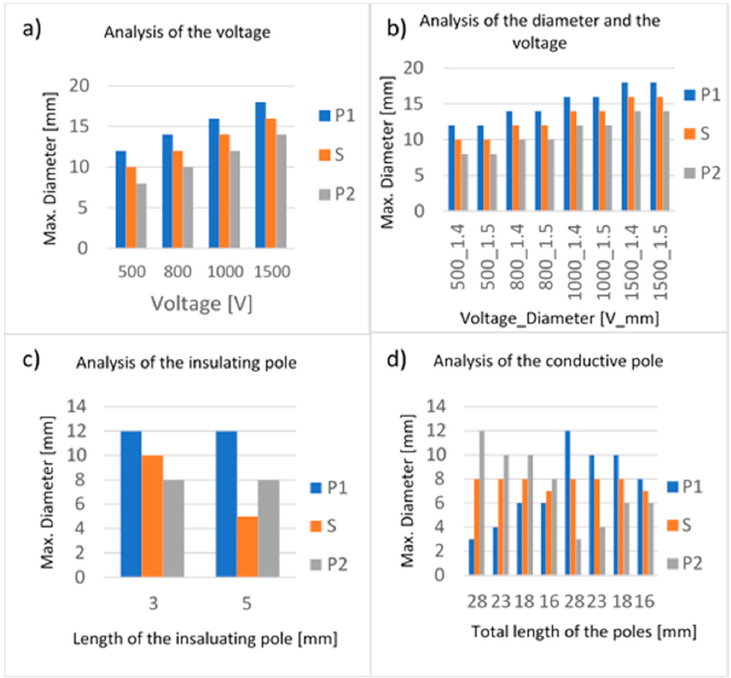
Figure 4. Histograms for tests with electrodes with asymmetric geometry (Test 5–8) of Figure 1. In ( a ), ( b ), ( c ) and ( d ) are reported the values of the maximum diameters measured at the distal pole (P1), spacer (S) and proximal pole (P2).